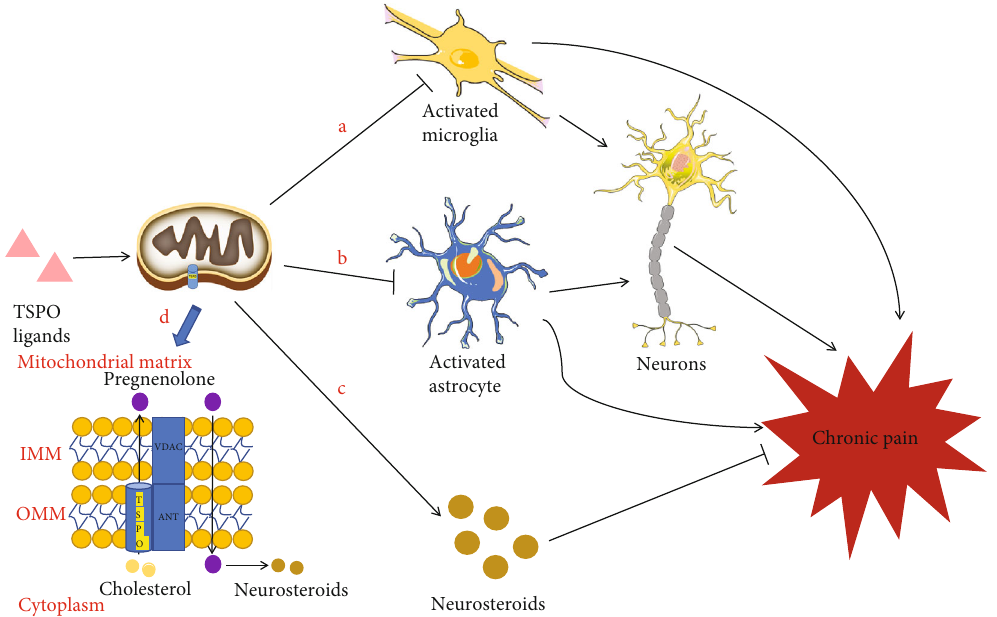
Figure 1: Mechanisms by which TSPO and its ligands inhibit chronic pain. (a, b) TSPO and its ligands inhibit microglial and astrocyte activation, thereby inhibiting activation-mediated central sensitization and chronic pain. (c) TSPO and its ligands inhibit chronic pain by mediating neurosteroid synthesis. (d) TSPO and its ligands promote cholesterol transport from the cytoplasm to the mitochondrial inner membrane, mediating progesterone synthesis and thus promoting neurosteroid synthesis. TSPO: translocator protein; IMM: inner mitochondrial membrane; OMM: outer mitochondrial membrane; VDAC: voltage-dependent anion channel; ANT: adenine nucleotide